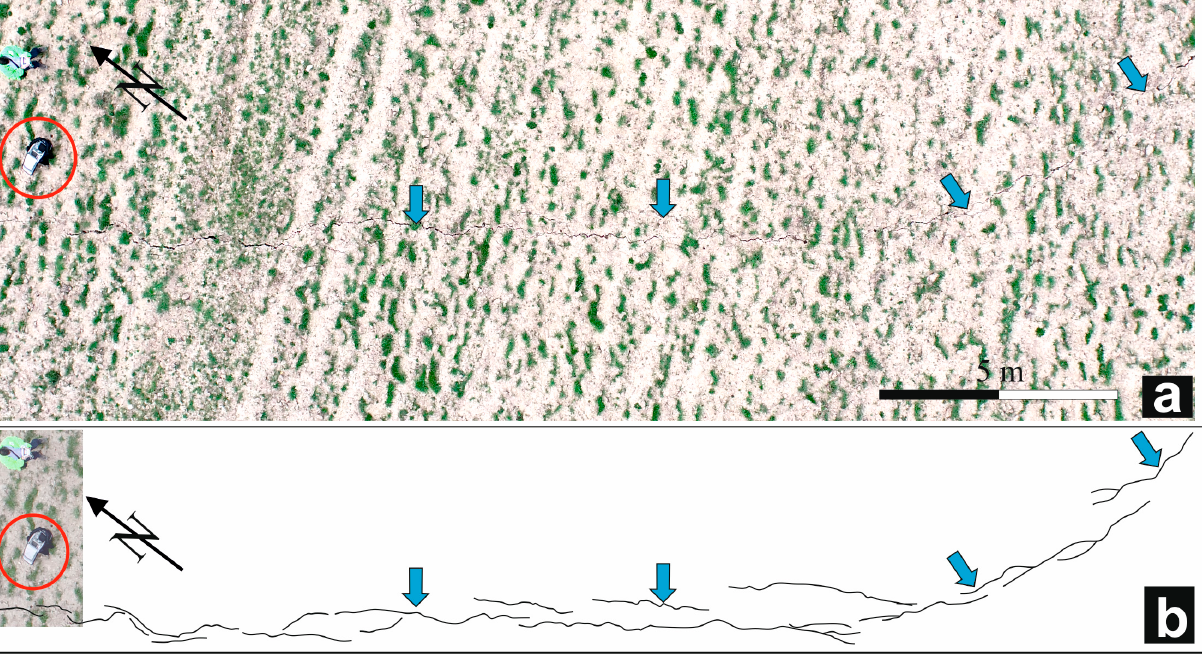
Figure 7. Fault scarp profiles across the VF coseismic ruptures (red arrow). For location of profiles, see the orthophoto map in Figure 8. Towards the southeast, the VF crosses the Palaeozoic gneiss, where a 5 m-thick cat- aclastic zone was observed, documenting a superposed brittle behavior, possibly sug- gesting recent shallow reactivations. In this sector, fresh surface ruptures were also rec- ognized at two locations associated with an array of open joints and small-scale rockfalls.